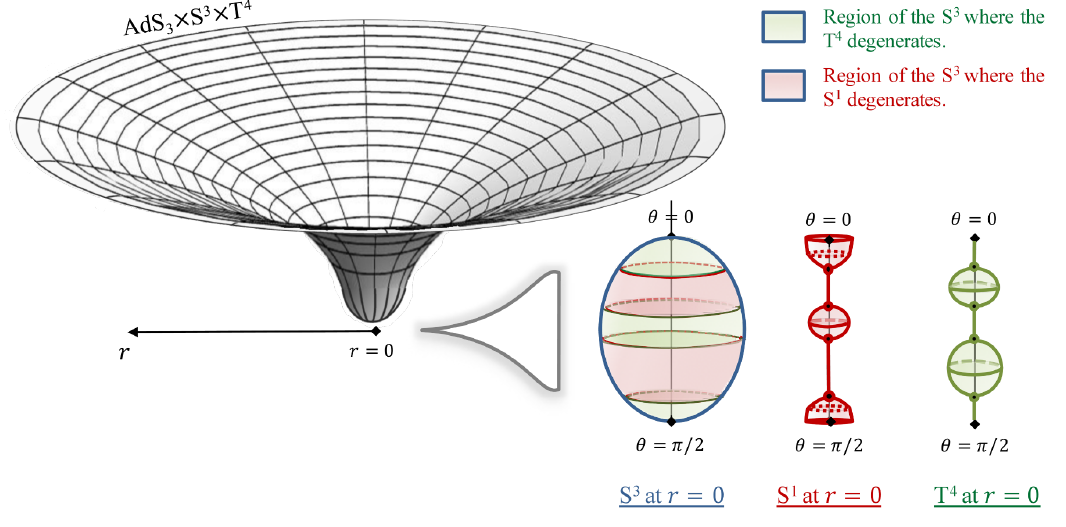
Figure 12 . Schematic description of the spacetime sourced by 5 connected rods, inducing the degeneracy of either the S 1 ( y ) or a T 4 direction. On the left-hand side, we depict the overall geometry in terms of r . On the right-hand side, we describe the behavior of the S 3 , S 1 , and T 4 at r = 0 and as a function of θ , giving the position along the S 3 . At r = 0 , the spacetime ends smoothly as a coordinate degeneracy of either the S 1 or the T 4 depending on the position on the S 3